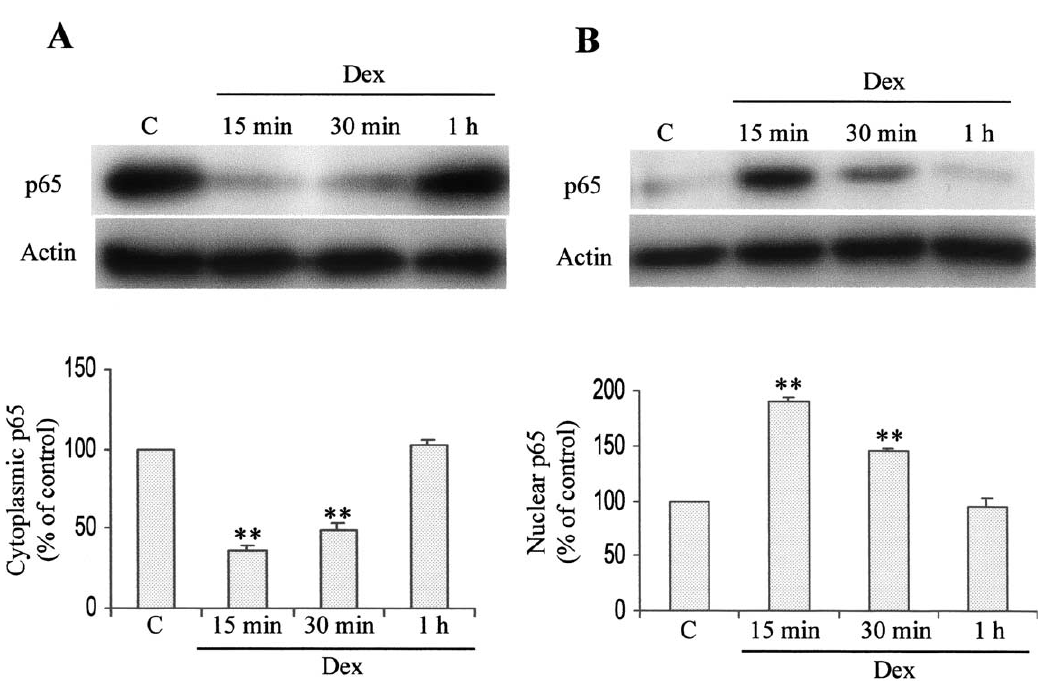
FIG. 2. Dex induces the translocation of the NF- k B protein p65 from the cytoplasm to the nucleus. CCRF-CEM cells were treated with Dex (1 m M) for the indicated periods. The cytoplasmic and nuclear extracts were prepared as described in Materials and methods. The p65 cytoplasmic (A) and nuclear (B) content were determined by western blot analysis, using a rabbit polyclonal anti-p65 antibody, and the bands were quantified with an image analyser. The results presented in the upper panels are representative of four independent experiments. The data shown in the lower panels are the average 9 / SD of four independent experiments. ** p B / 0.01, as determined by one-way analysis of variance with Dunnett’s post test.